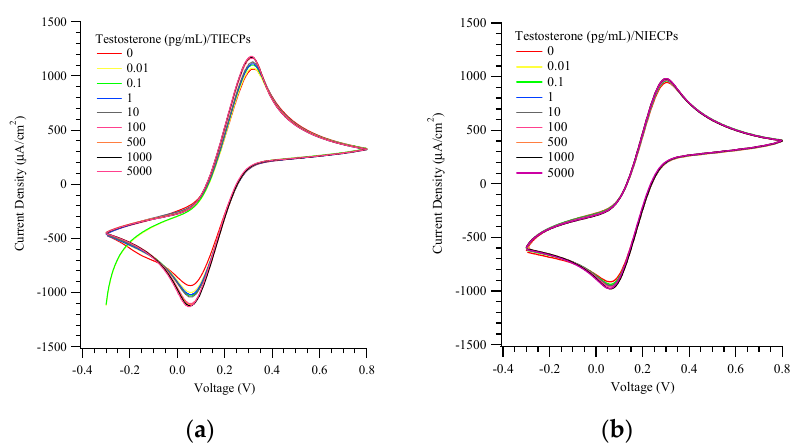
Figure 4. Cyclic voltammograms of various target concentrations on ( a ) testosterone- (TIECPs) and ( b ) non-imprinted poly(aniline-co-metanilic acid) (NIECPs) coated electrodes.